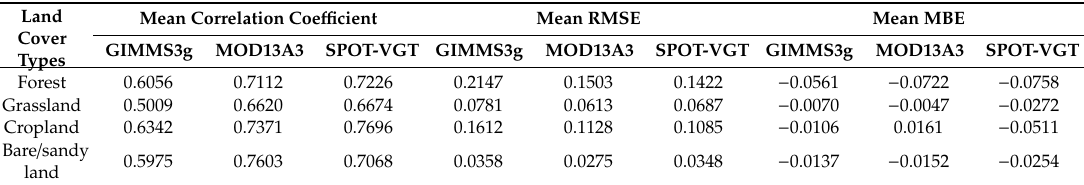
Table 7. Average values of statistic scores between Landsat 8-based NDVI and the corresponding three NDVI products over di ff erent land cover types in the